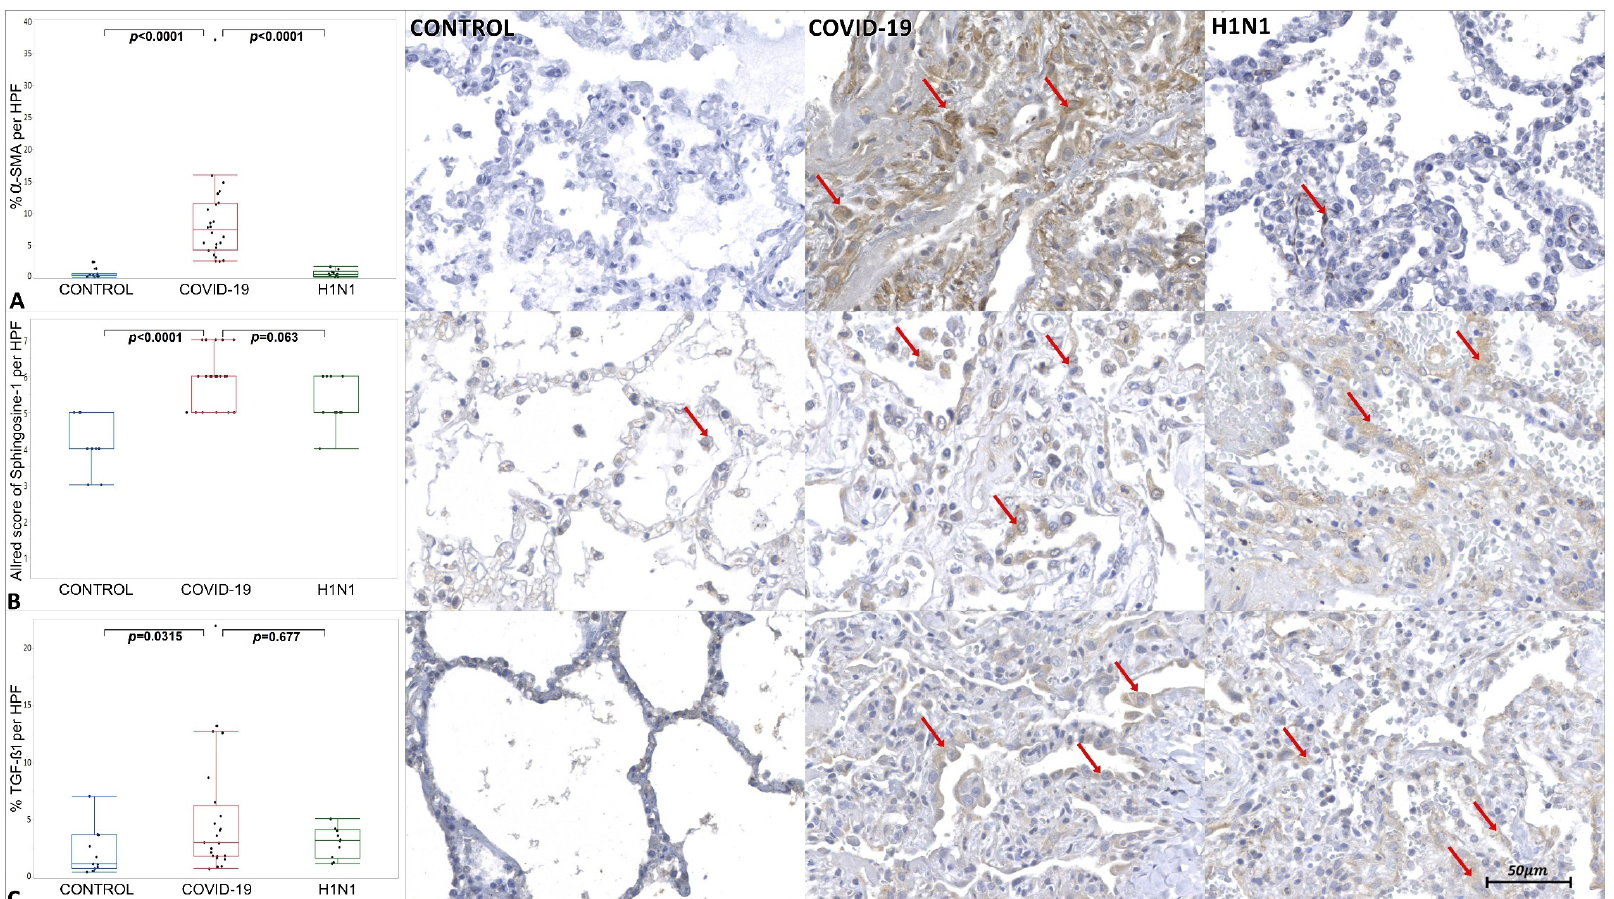
Figure 3. Graphics show tissue immunoexpression of α -SMA and TGF- β 1 (percentage per HPF) and Sphingosine-1 (M2 macrophages and type II pneumocytes Allred score). ( A ) Comparative graphs between the CONTROL, COVID-19 and H1N1 groups and photomicrographs of tissue immunoexpression of α -SMA in alveolar epithelium represented by the red arrow, of the respective groups. ( B ) Comparative graphs between the CONTROL, COVID-19 and H1N1 groups and photomicrographs of tissue immunoexpression of Sphingosine-1 M2 macrophages and type II pneumocytes, represented by the red arrow, of the respective groups. ( C ) Comparative graphs between the CONTROL, COVID-19 and H1N1 groups and photomicrographs of tissue immunoexpression of TGF- β 1 in the alveolar epithelium, represented by the red arrow, of the respective groups.